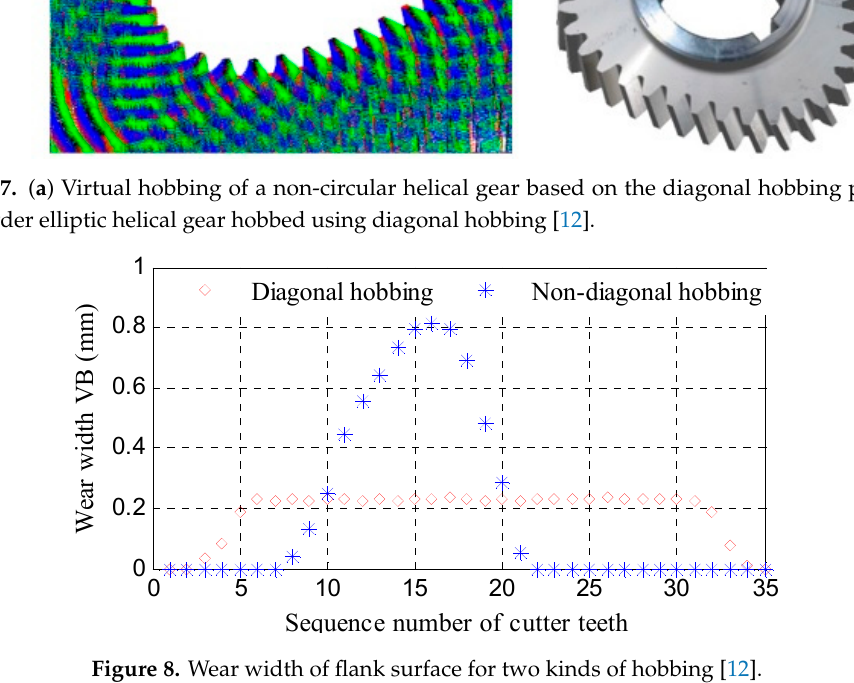
Figure 8. Wear width of flank surface for two kinds of hobbing [12].